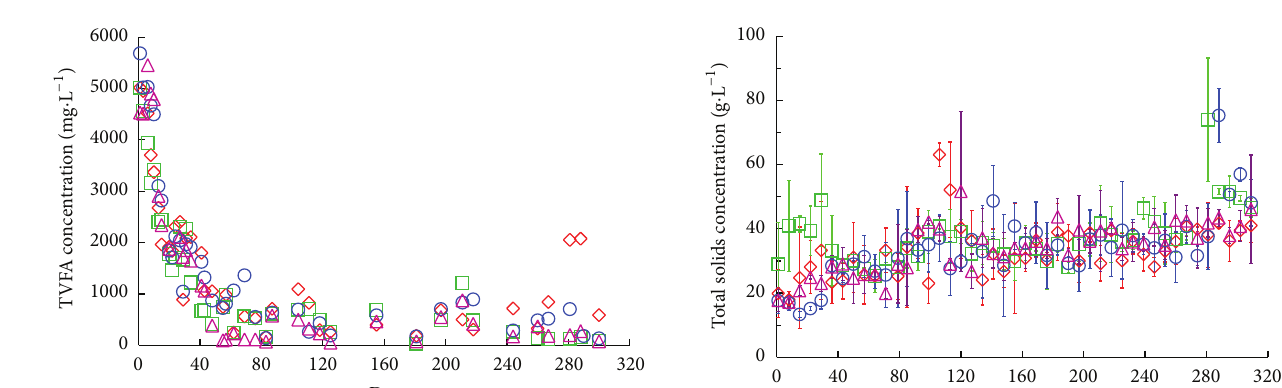
= ⬦ ; 𝑅 = I ; control- 1 control- 2